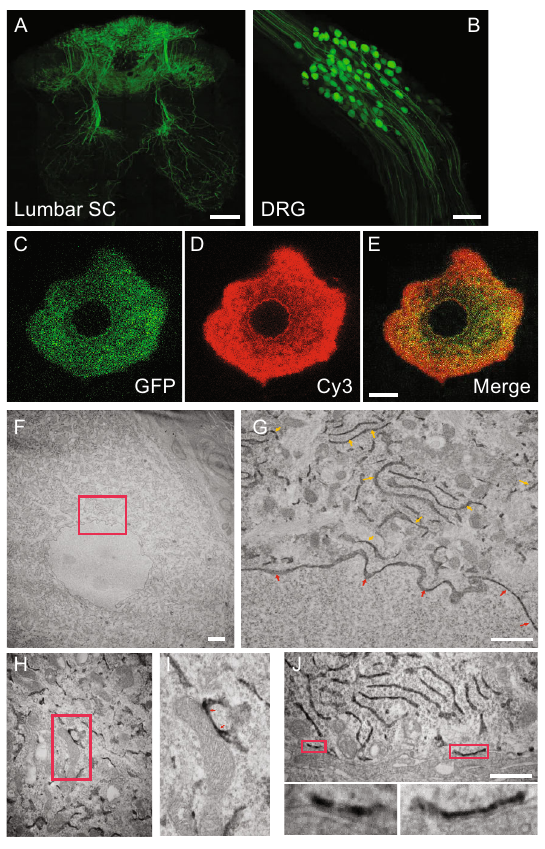
Figure 2. Topology of S1R in primary DRG neurons trans- duced with AAV2/8 . (A) Fluorescent image of a rat lumbar spinal cord section transduced with AAV2/8-EGFP 4 weeks earlier. Dorsal(top)andventral(bottom).(B)Astackedconfocalimageof a lumbar DRG from the same rat. Transduced EGFP-expressing DRG neuronal cell body and the neurites extending both proximally (top) and distally (bottom) can be seen. (C – E) A fl uorescent image of a single neuron from a rat transduced with AAV2/8(S1R-EGFP-APEX2;C-terminus-taggedfull-lengthS1R) 4 weeks earlier. The GFP-image shows successful expression of the EGFP reporter, and the Cy3-image shows the same neuron probed with streptavidin-Cy3 after reacted the DRG section with H 2 O 2 and biotin-phenol for proximity-labeling. The merge image shows a complete overlap of the two signals. (F and G) An EM imageofaDRGneuronfromthesamerat.ER(yellowarrows)and nuclear membrane (red arrows) of the magni fi ed area within the red box show electron-dense precipitates within the ER lumen and the inter-nuclear membrane space. (H and I) Electron-dense precipitationcanbeobservedinERassociatedwithmitochondria (i.e., mitochondria-associated membrane) (red arrows). (J) Elec- tron-dense precipitation is observed in subsurface cisterns, but not in the plasma membrane (PM). Lower panels are magni fi ed images of subsurface cisterns outlined in the red box in the upper panel. Yellow arrows point to the plasma membrane. Scale bar: A = 200 µm; B = 100 µm; C – E = 10 µm; F = 2 µm; G = 1 µm; H = 1 µm; I = 0.5 µm; J = 0.5